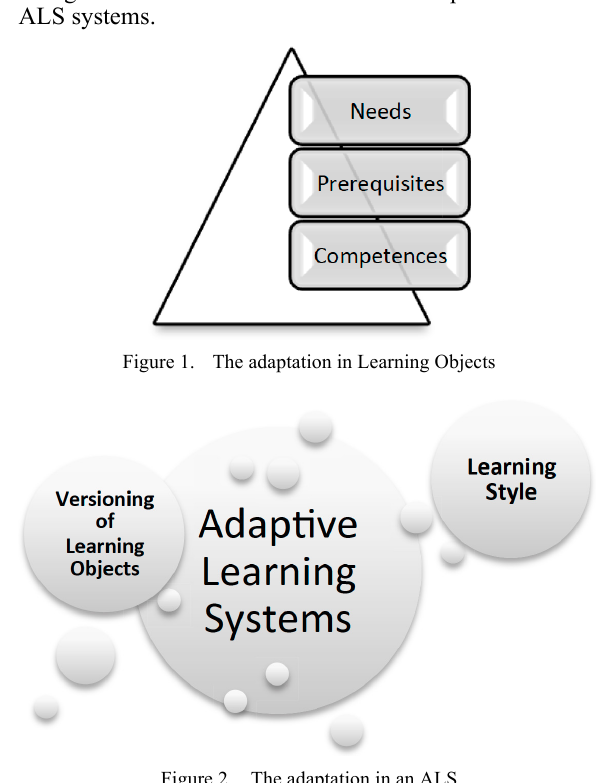
Figure 2. The adaptation in an